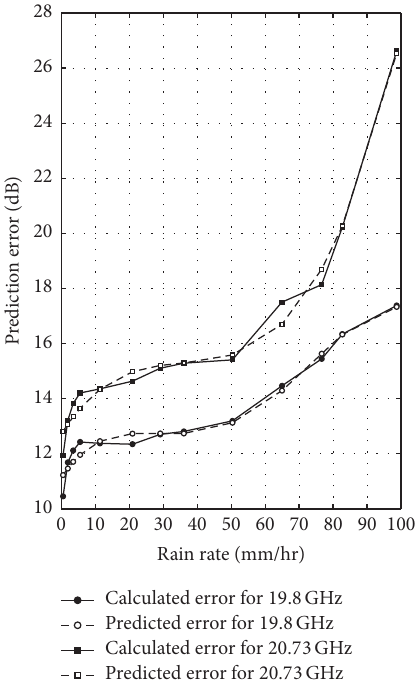
Figure 10: Cumulative distribution of rain attenuation obtained after frequency scaling for 19.8 GHz [20].